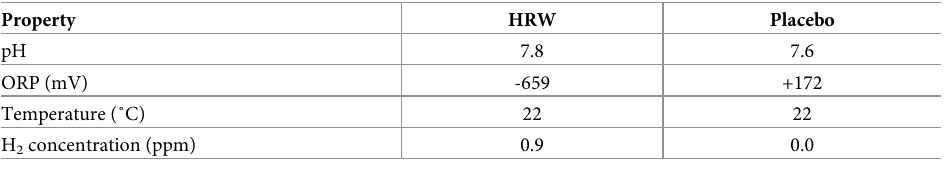
Table 2. Physico-chemical properties of hydrogen rich water and placebo water. Property HRW pH ORP (mV) -659 +172 Temperature (˚C) 22 22 H 2 concentration (ppm) 0.9 0.0 HRW = hydrogen rich water; ORP = oxidation reduction